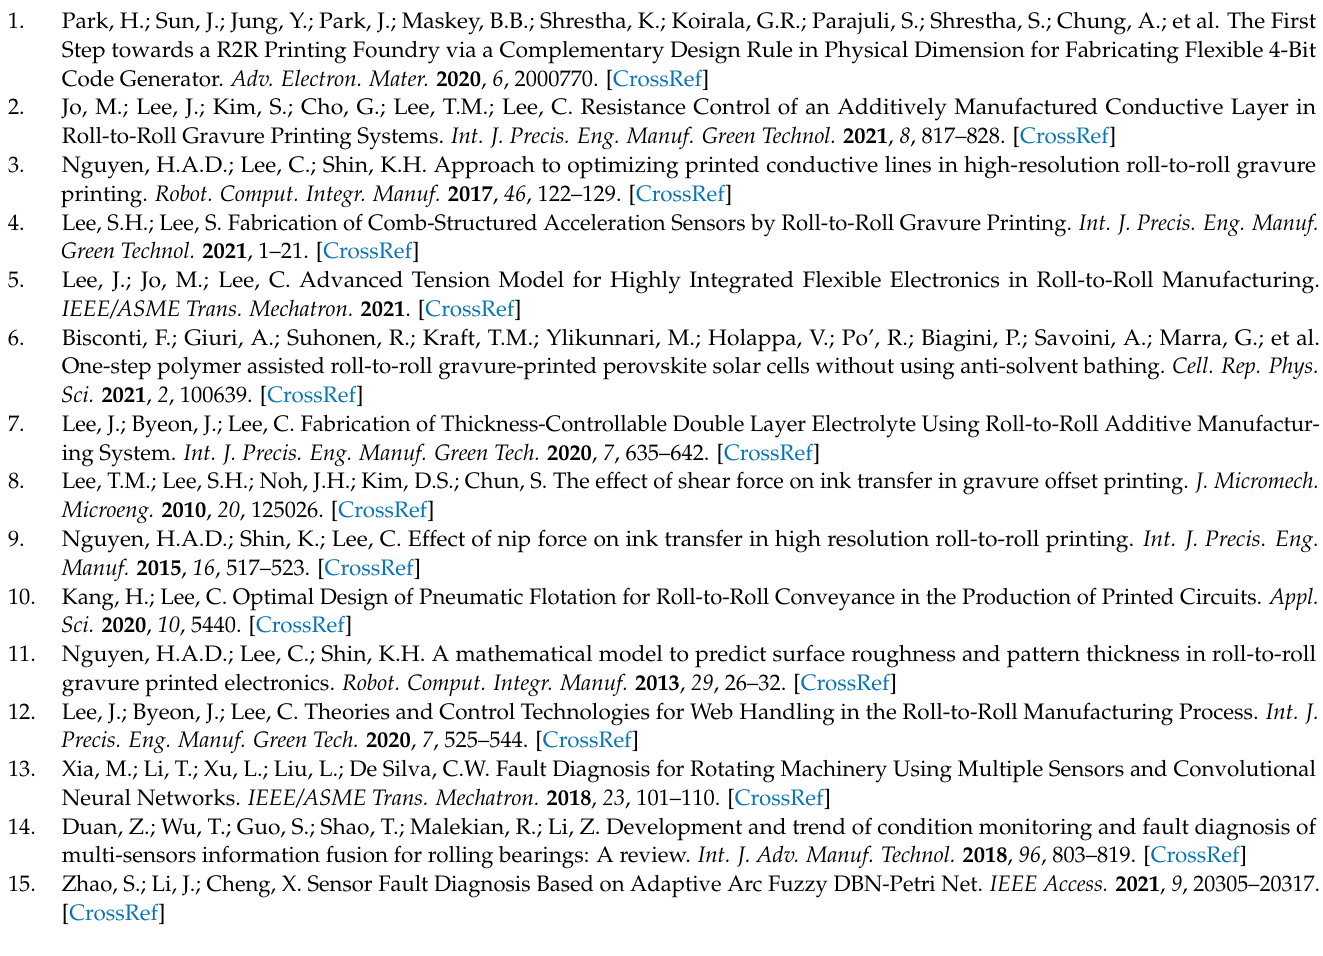
Table S32. Doctor blade tilting fault diagnosis with various machine learning algorithms, Table S33. Printing roll eccentricity fault diagnosis with various machine learning algorithms, Table S34. Nip roll eccentricity fault diagnosis with various machine learning algorithms, Table S35. Nip force non-uniformity fault diagnosis with various machine learning